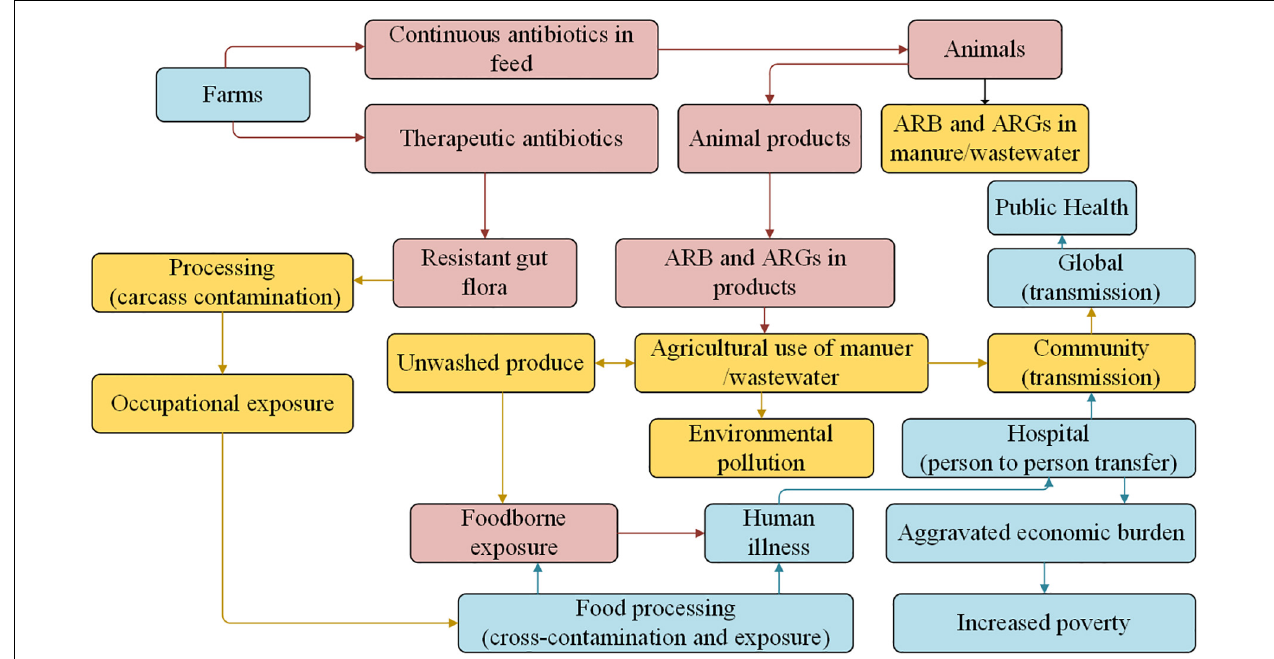
FIGURE 3 | Multiple pathways involved in ARB and ARGs in the food animal and human health (Koch et al., 2017).